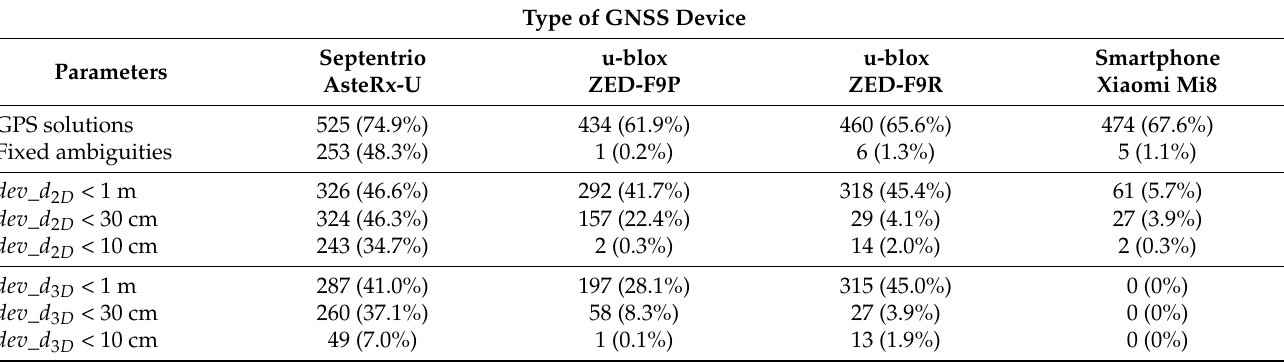
Table 9. GPS solutions, solutions with fixed ambiguities, and deviation of distances below the given threshold. Situation: Case B—urban area (no. of total solutions: 700).